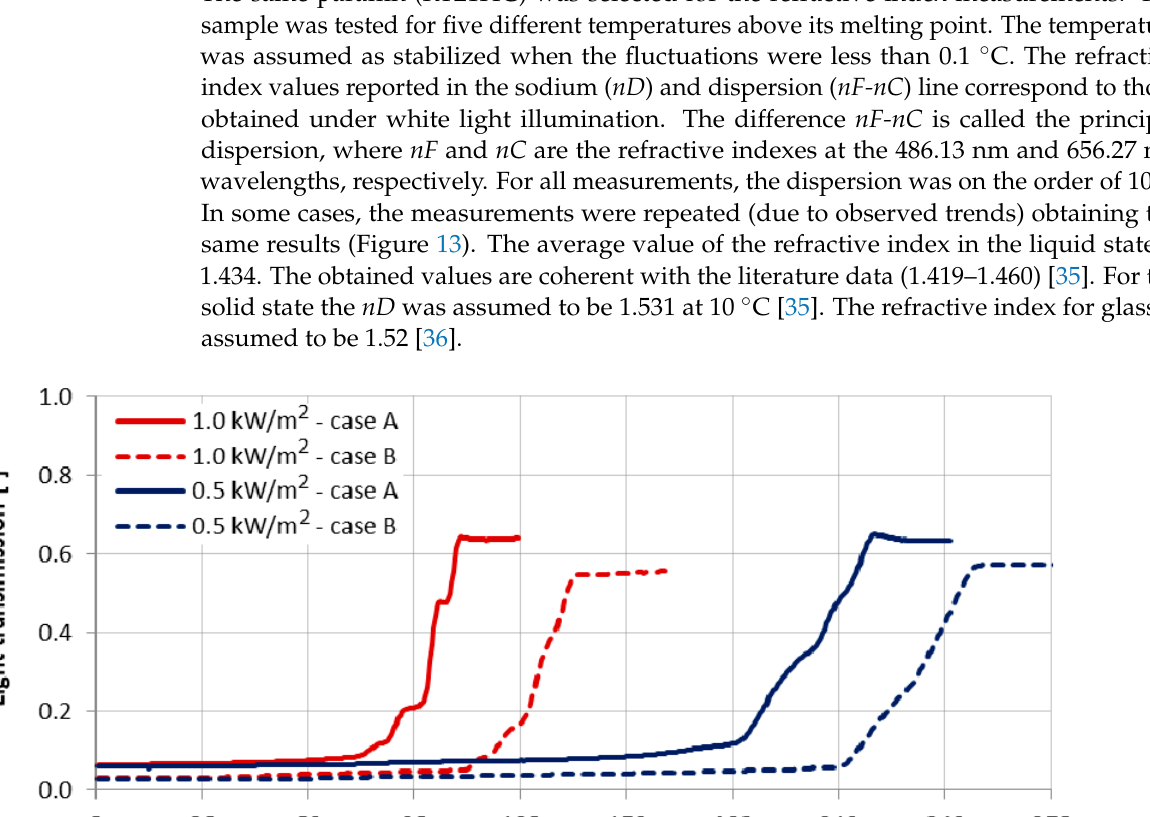
Figure 5. Krüss AR4 refractometer used in the experiments.